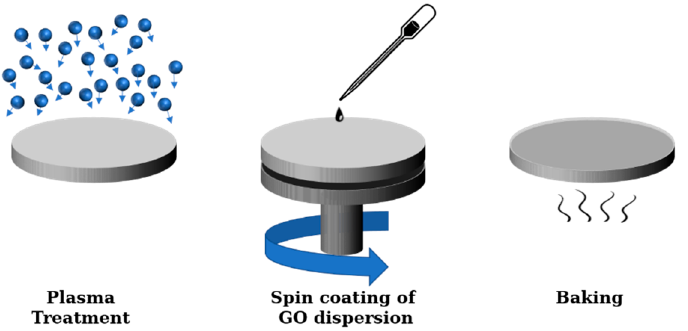
Figure 1 . Schematic illustration of the experimental procedure followed to deposit GO films on COC substrates via spin coating. substrates via spin